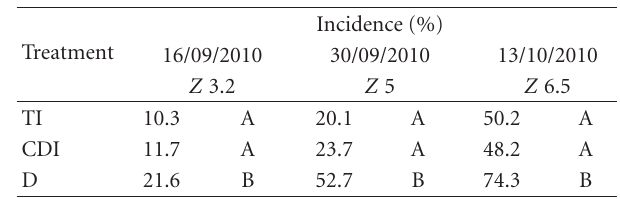
Table 7: Incidence (%) of foliar disease onset for individual phenological states under total irrigation (TI), irrigation with controlled deficit (CDI), and dry (D) treatments.